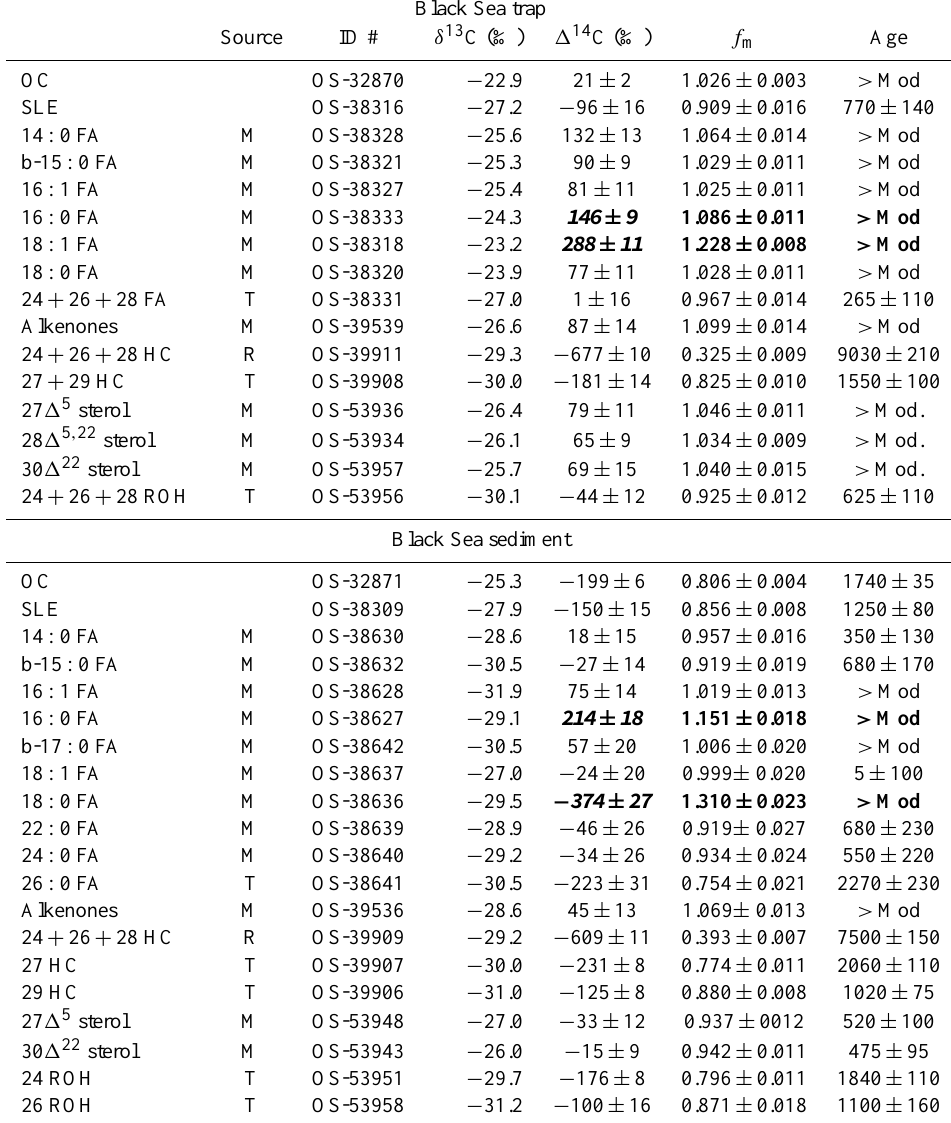
Table 1. Stable carbon and radiocarbon isotope data for Black Sea POM and SOM. Bold italicized values were not used in calculations (see